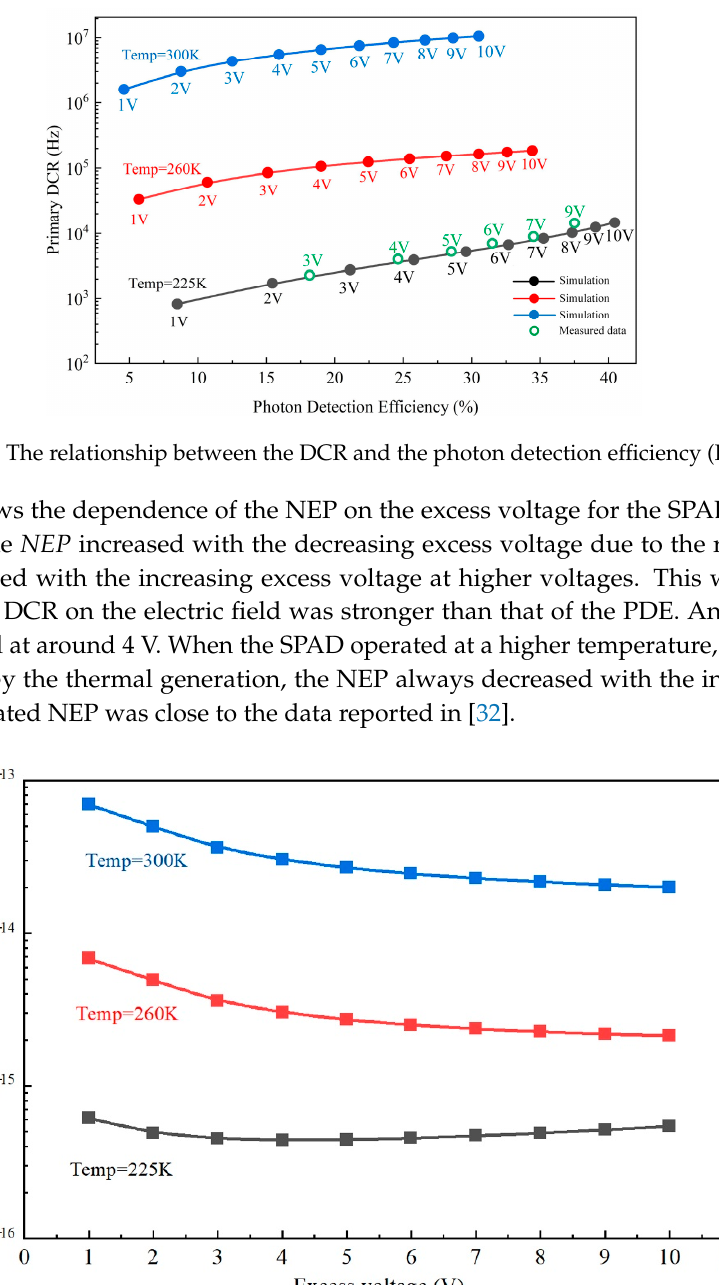
10 of 13 Figure 7. The variety of the total DCR with gate-OFF times. To apply the developed InP/InGaAs SPAD model to different working conditions, the DCR was predicted under different temperatures and excess voltages, as shown in Figure 8. As can be seen in the figure, a low operating temperature and a small excess voltage were good for improving the dark noise, but they would deteriorate the photon detection efficiency. By comparing the trends in Figure 8a,b, it can be seen that the DCR’s temperature dependence was stronger than its excess voltage dependence. Therefore, an InP/InGaAs SPAD operating at a low temperature is preferred in practical applications. ( a ) ( b ) Figure 8. ( a ) Simulation results of the primary DCR with temperatures at three different excess voltages. ( b ) Simulation results of the primary DCR with excess voltages at five different temperatures. As the excess voltage increased, the PDE at 1550 nm improved thanks to the higher avalanche probability. Unfortunately, the primary DCR also increased because of the electric field-related impact ionization coefficients and the tunneling mechanism. Thus, the SPAD needed a trade-off between the DCR and the PDE. Figure 9 shows the relationship between the primary DCR and PDE at different operating temperatures. As shown in the figure, the simulation results accorded well with